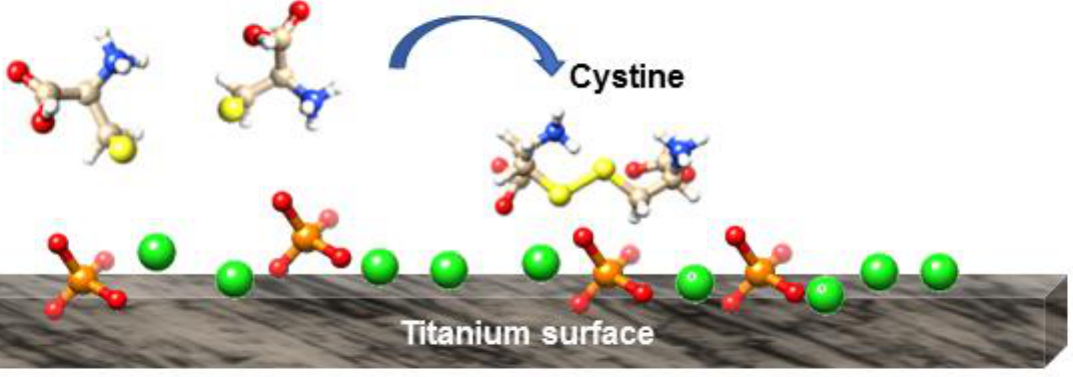
Figure 5. Proposed adsorption behavior of the investigated molecule (Cys) in the dried system on the Ti surface.